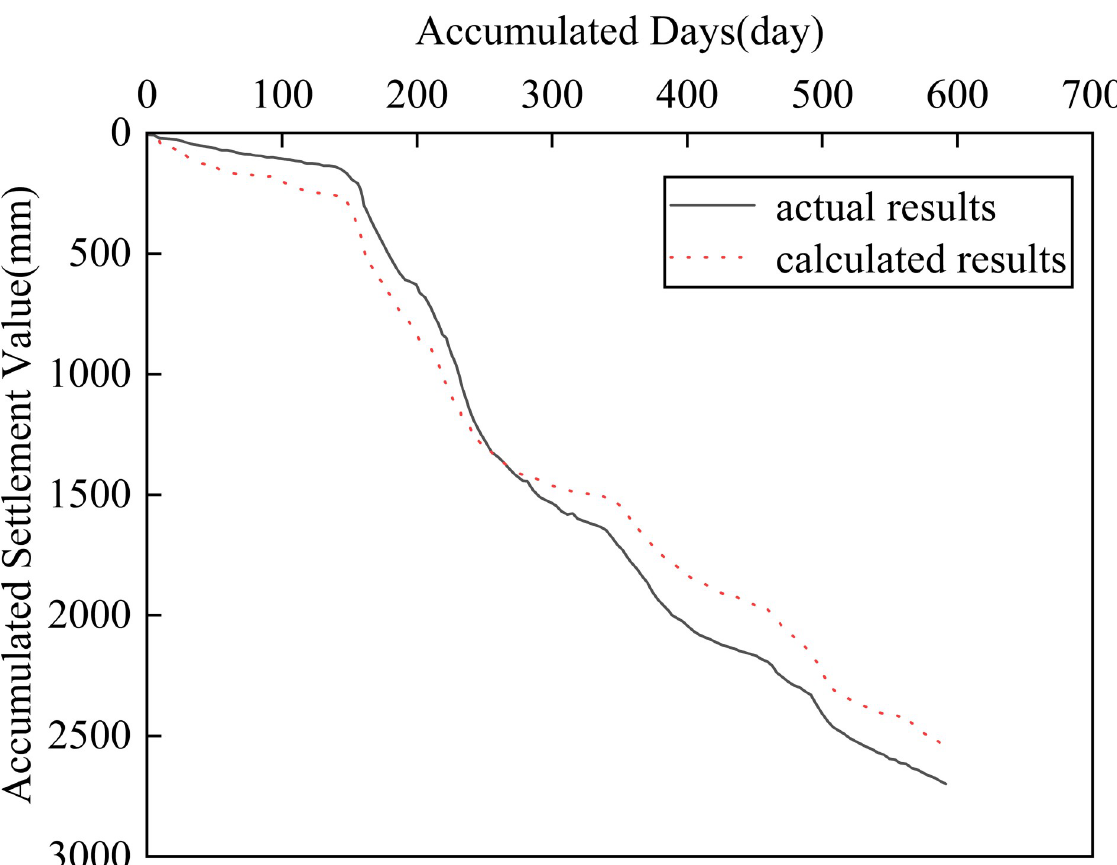
Fig 7. Settlement-time curve of the 1.5 m